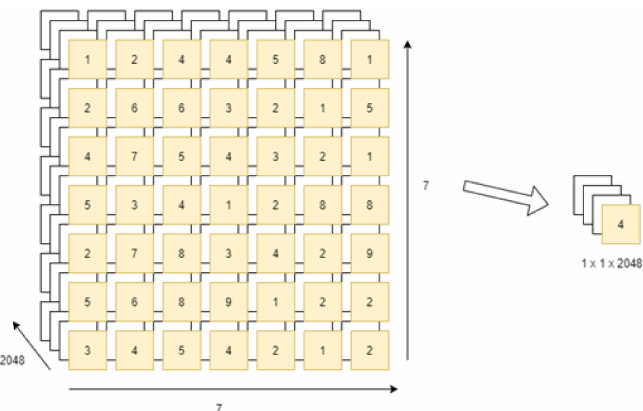
Figure 7. Global average 2D pooling